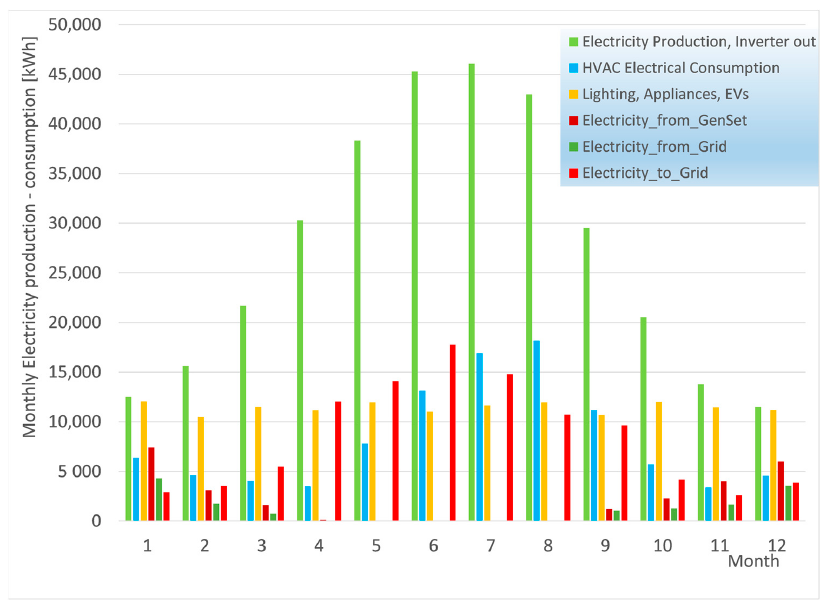
Figure 6. Monthly electricity production, consumption and export to the grid during one full year (20 kW Genset). (20 kW